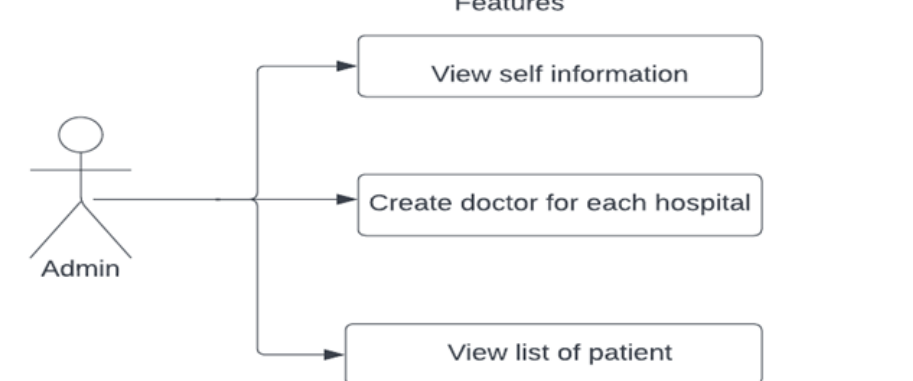
Figure 4. Illustration of the admin persona (or features).